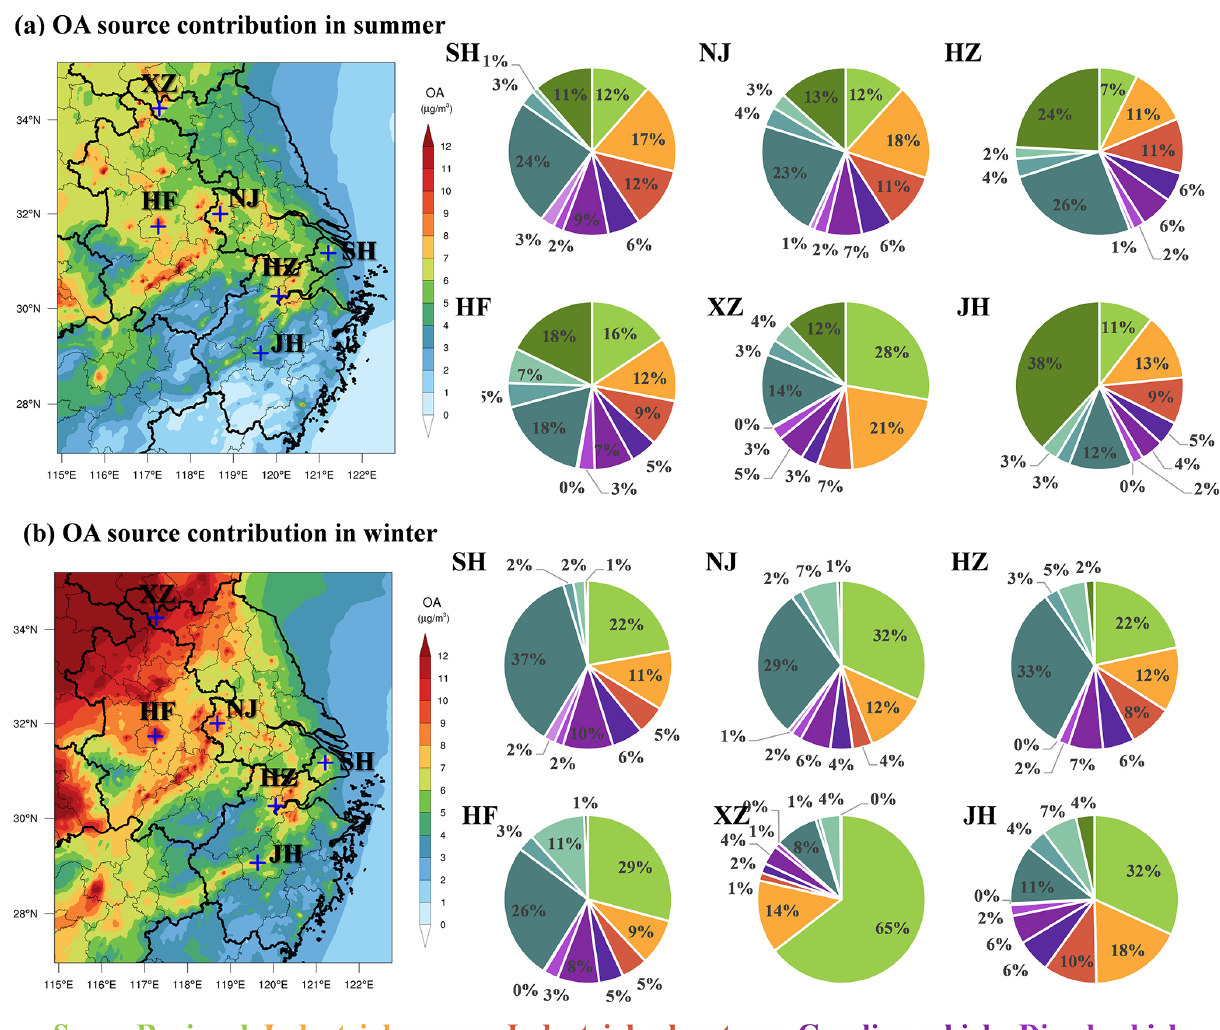
Figure 9. Source contributions of modeled OA concentrations from different sources during summer and winter in different cities of the